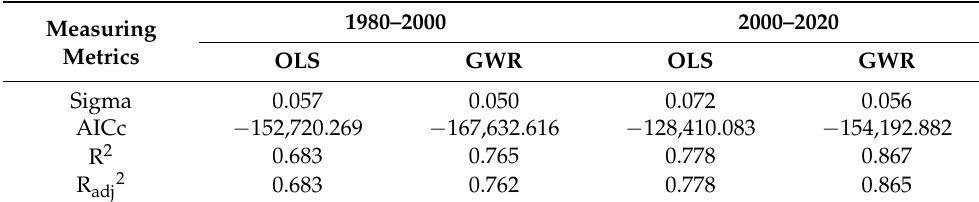
Table 4. Comparison of two regression models.